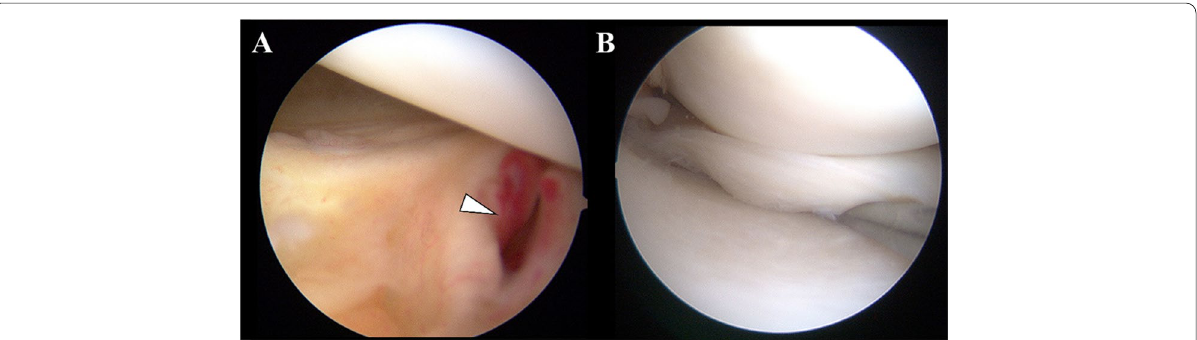
Fig. 1 Systematic arthroscopic evaluation of ramp lesions. A The meniscocapsular junction is directly assessed by intercondylar viewing. B Second, the medial meniscus is evaluated through the anterolateral portal with probing. Arrowhead marks meniscocapsular tear of the posterior horn of the medial